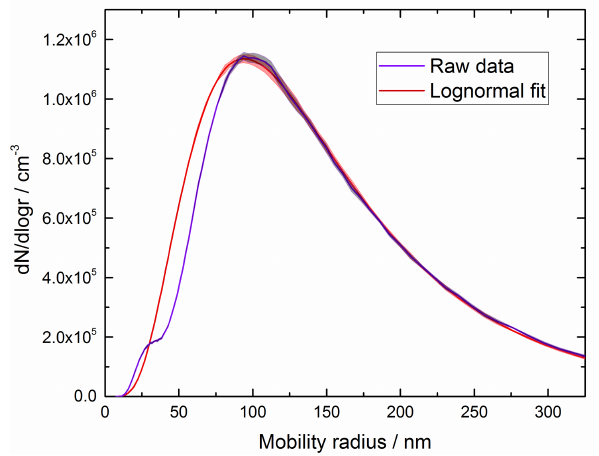
Figure 5. Measured size distribution (purple) and a lognormal fit to the experimental data (red) with shaded areas indicating the experi- mental uncertainty.